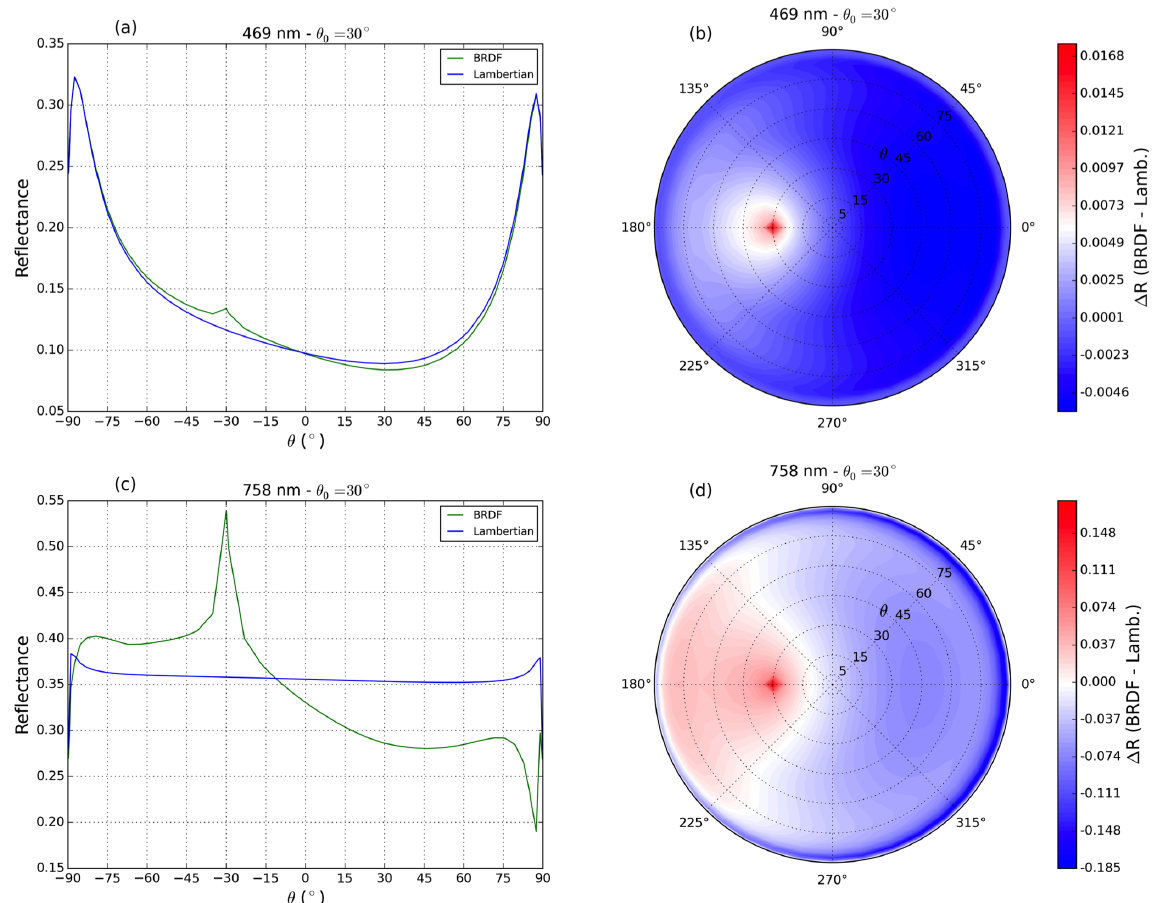
Figure 6. (a, c) TOA reflectance as a function of viewing zenith angle simulated by DAK at 469 and 758nm with a Lambertian sur- face (blue line) and with surface BRDF (green line) in the principal plane ( ϕ − ϕ 0 = 180 ◦ for negative θ and ϕ − ϕ 0 = 0 ◦ for positive θ ). (b, d) Absolute differences between TOA reflectance with surface BRDF and with a Lambertian surface at 469 and 758nm. Surface BRDF parameters represent a vegetated surface over Amazonia at 469nm ( f iso , f vol , f geo ) = ( 0 . 0399 , 0 . 0245 , 0 . 0072 ) and 758nm ( f iso , f vol , f geo ) = ( 0 . 36 , 0 . 24 , 0 . 03 ) . Note the different